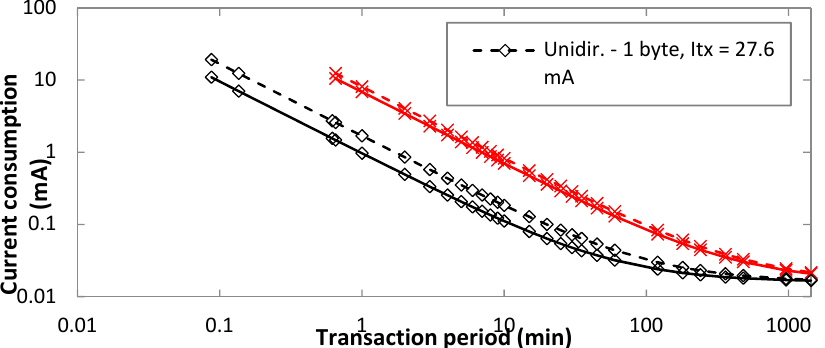
Figure 13. Average current consumption of the device, for different transaction types, as a function of I tx , for FLR = 0, and for different uplink payload size of 1 byte.